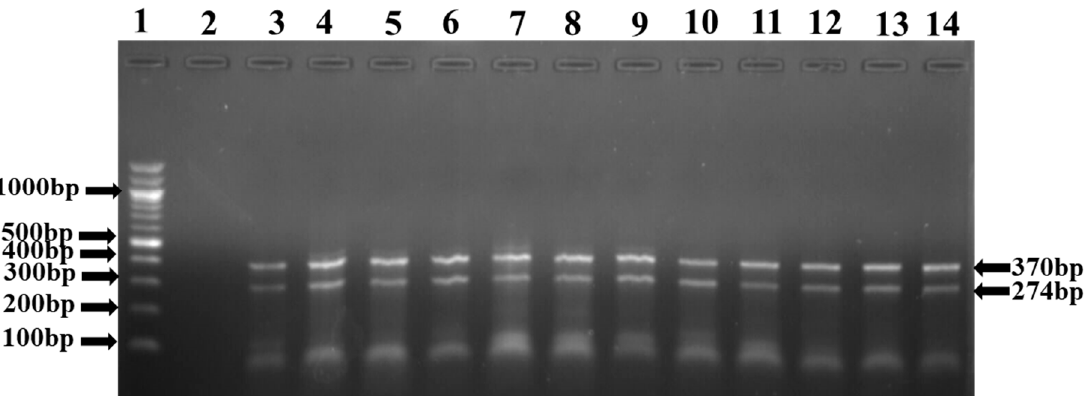
of listeria genus and Listeria monocytogenes , respectively. Lane 1: Molecular weight Marker (100 bp); Lane 2: Negative control, Lane 3–14: Listeria species.